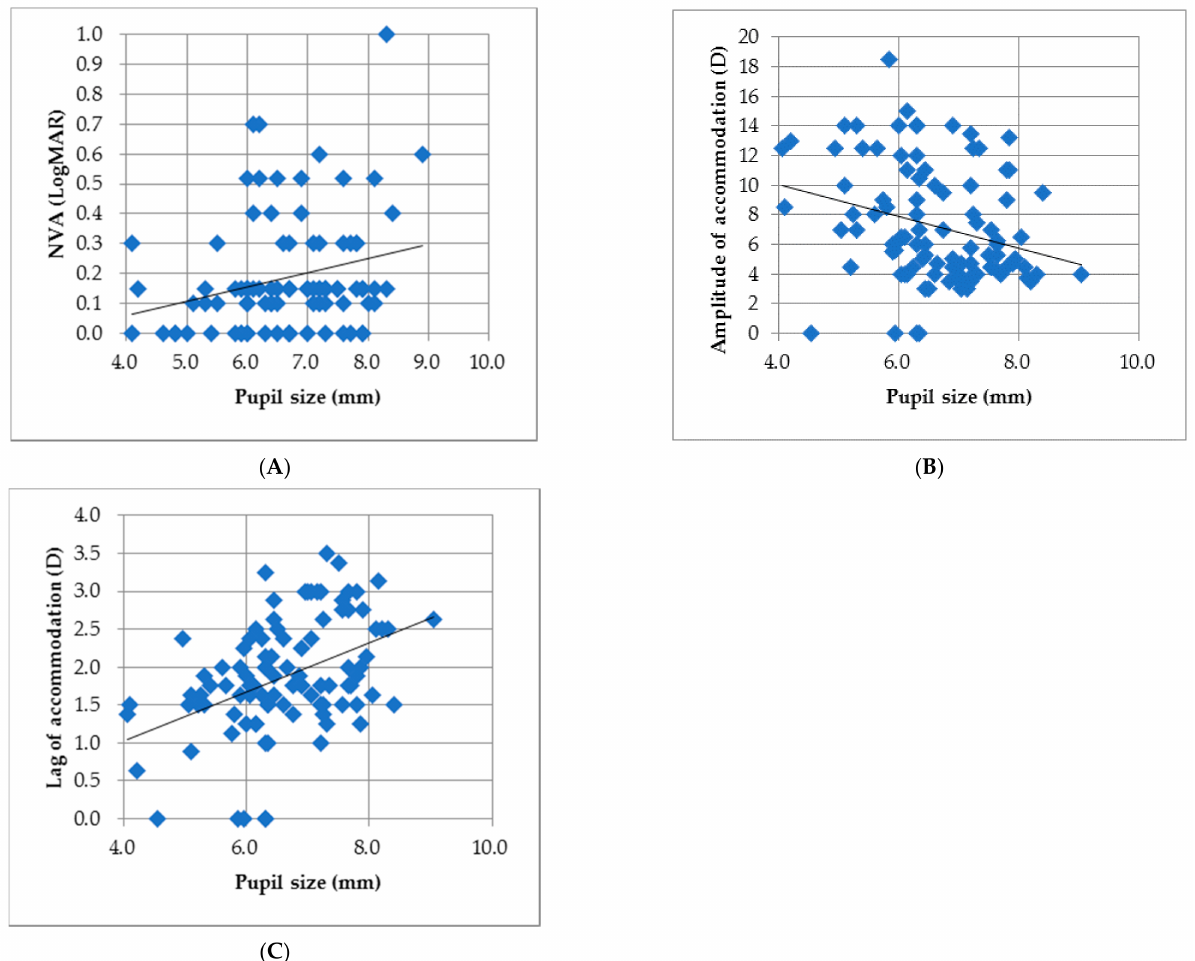
Figure 1. Statistically significant correlations were found between ( A ) pupil size and near LogMAR acuity (r = 0.254, p = 0.012); ( B ) pupil size and amplitude of accommodation (r = − 0.275, p = 0.006); ( C ) pupil size and accommodative lag (r = 0.428, p < 0.0001) in the atropine